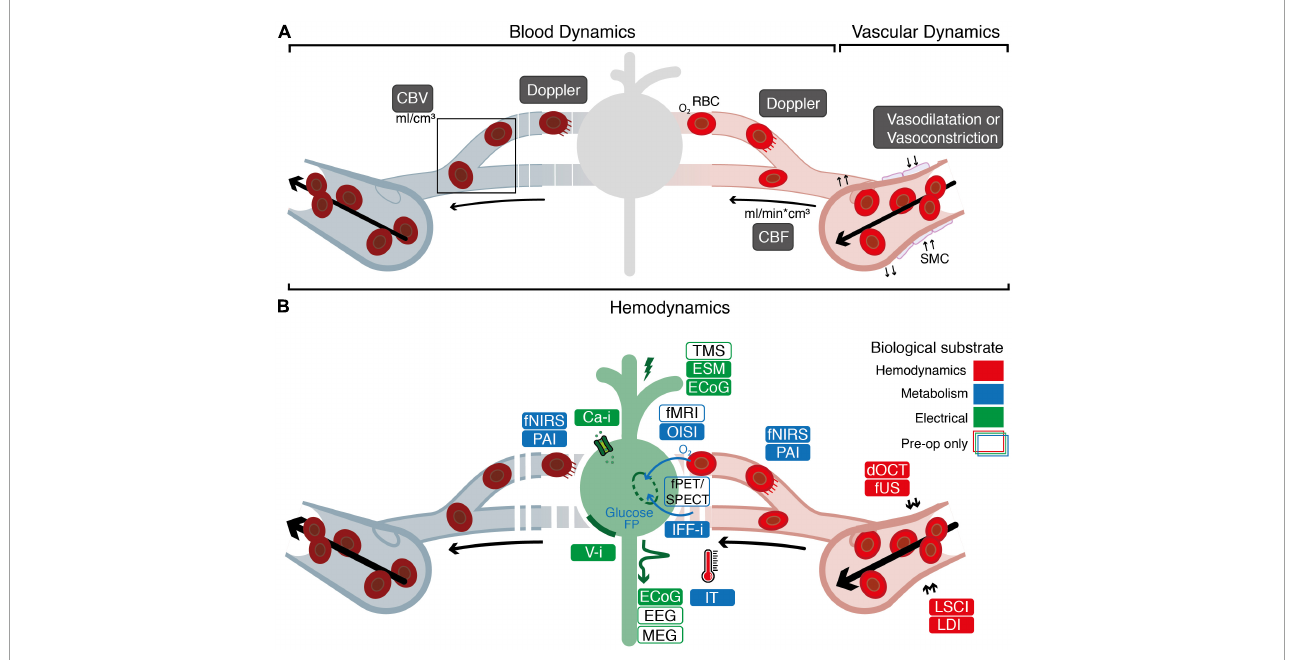
FIGURE1 Overview of the biological substrates underlying different functional imaging techniques. (A) Graphical overview of the relationship between blood dynamics, vascular dynamics and hemodynamics. Blood dynamics consists of changes in CBV (the volume of blood in a volume of brain) and changes in CBF (the speed with which a volume of blood perfuses a volume of brain). Vascular dynamics specifically encompasses vasoconstriction and vasodilatation, mediated by smooth muscle cells (SMCs) surrounding larger veins, arteries and smaller arterioles. “Hemodynamics” is used as an overarching term encompassing blood and vascular dynamics. (B) Electrical techniques ( depicted in green ) rely on detection of electrical signal (ECoG, EEG, MEG) or direct proxies thereof (Ca-I, V-i) to measure neuronal activity. Alternatively, techniques such as ESM or ECoG rely on introduction of electrical current into the brain to actively produce or interrupt neuronal activity. Through the principles of neurovascular coupling (NVC), electrical neuronal activity is linked to changes in hemodynamics, which underlies techniques such as dOCT, fUS, LDI, and LSCI ( depicted in red ). This neurovascular response is closely interwoven with the metabolic requirements for neuronal activity known as neurometabolic coupling (NMC). Techniques such as IFF-I, IT, OISI, PAI, fNIRS, fPET/SPECT, and fMRI rely primarily on measurements of metabolites as a proxy for functional activity ( depicted in blue ). White boxes indicate pre-operative techniques specifically. ECoG, electrocorticography; EEG, electroencephalography; MEG, magnetoencephalography; ESM, electrocortical stimulation; TMS, transcranial magnetic stimulation; Ca-i, calcium-imaging; V-i, voltage-imaging; NVC, neurovascular coupling; PAI, photo-acoustic imaging; fNIRS, functional near-infrared spectroscopy; dOCT, Doppler optical coherence tomography; fUS, functional ultrasound; LDI, laser Doppler imaging; LSCI, laser speckle contrast imaging; RBC, red blood cells; NMC, neurometabolic coupling;